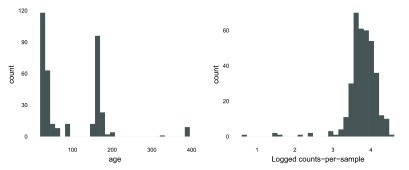
Preliminary plots suggest certain preprocessing steps.The histogram on the left motivates the creation of a new categorical variable, binning age into one of the three peaks. The histogram on the right suggests that a log (1 +
x) transformation is sufficient for normalizing the abundance data.